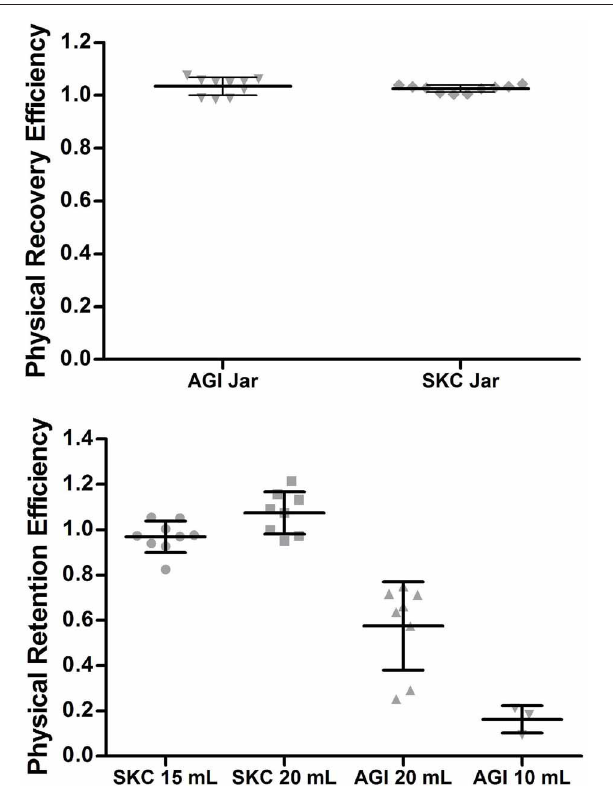
FIGURE 3 | Physical recovery and retention efficiencies of 1 µ m fluorescent melamine beads from impinger jars. Top: Physical recovery efficiency; n = 10 for each jar type; Bottom: Physical retention efficiency; n = 9 for SKC filled with 15ml; n = 8 for SKC filled with 20ml; n = 8 for AGI filled with 20ml; n = 3 for AGI filled with 10ml; lines represent the mean and ± one standard deviation.